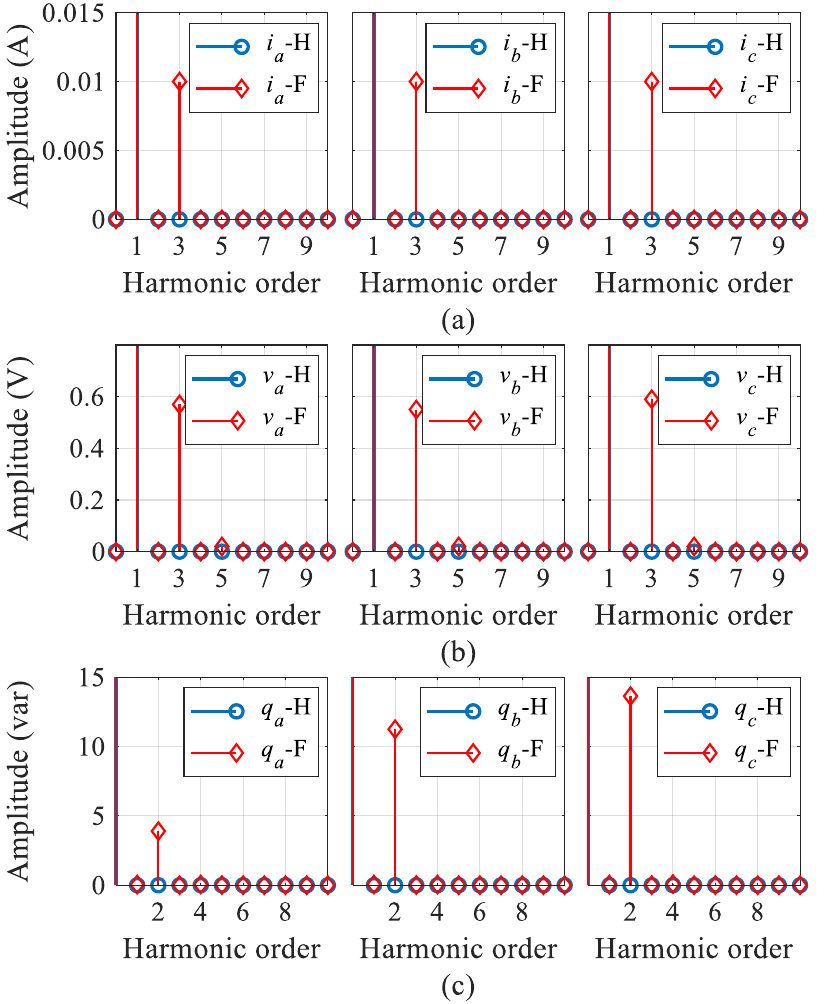
Figure 4. The spectra of currents ( a ), voltages ( b ) and phase IRPs ( c ) in healthy and faulty cases. The same operating conditions and fault severity as that in Figure 3. same operating conditions and fault severity as that in Figure 3.